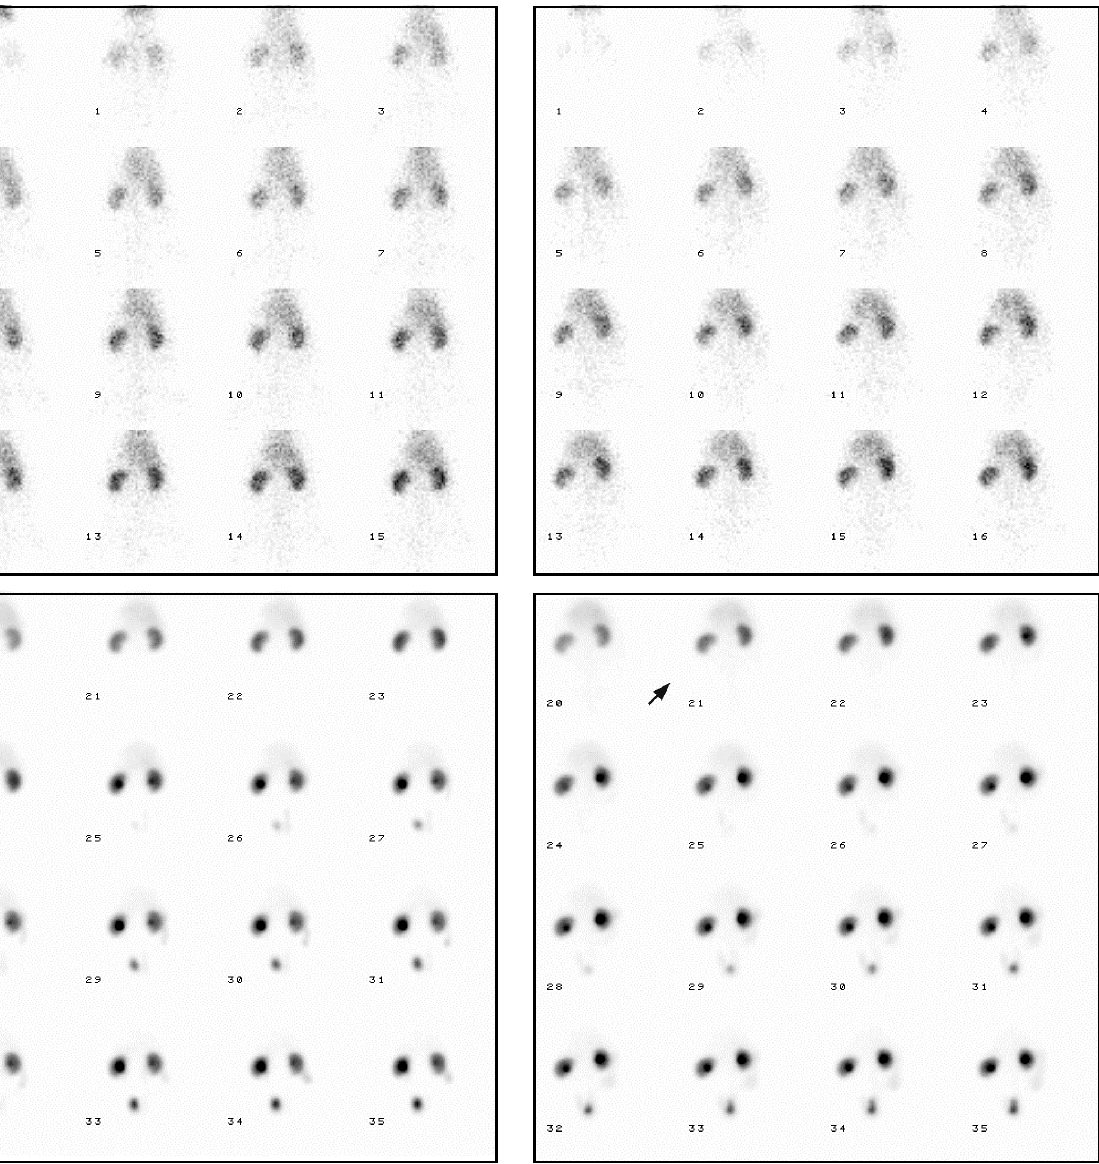
Figure 03 - Ischemia with chlorpromazine (group C). Basal study (A1 and A2), with normal pattern, and 24-hour phase (B1 and B2), with just mild decrease of left renal function (not statistically significant; p<0,05;